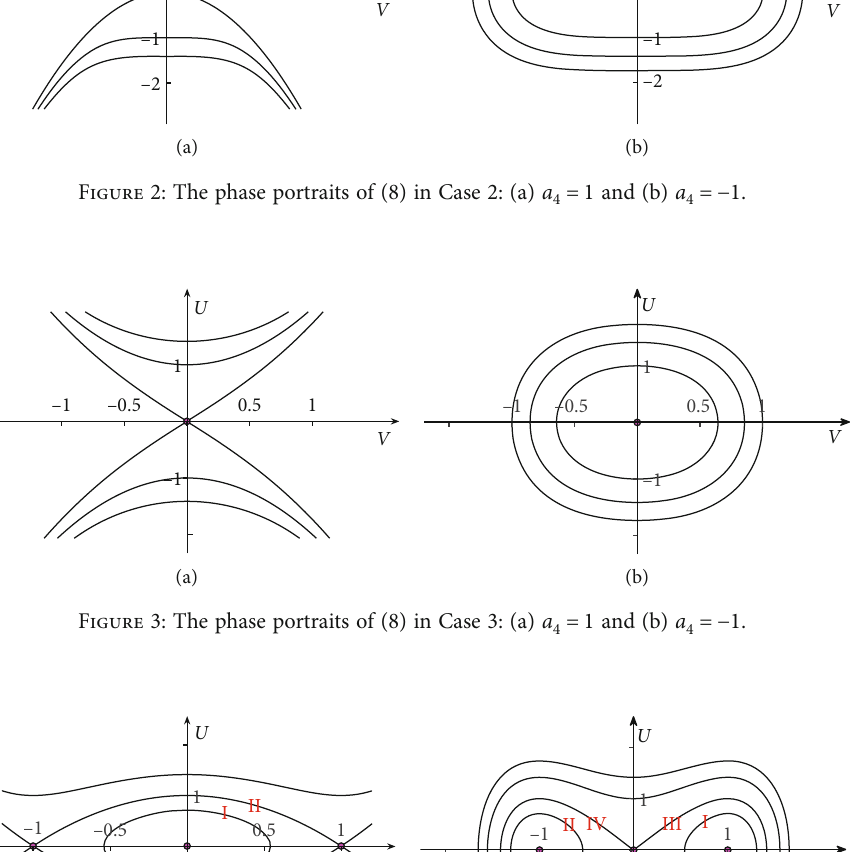
Figure 4: The phase portraits of (8) in Case 4: (a) a